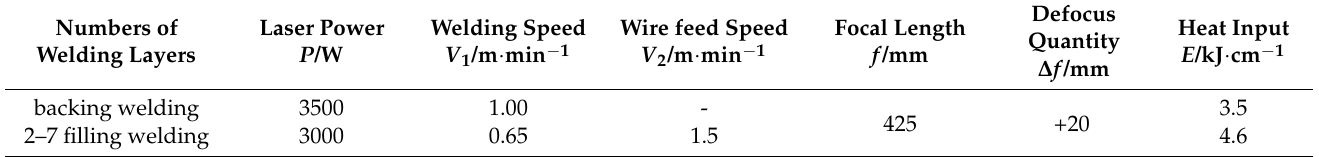
Figure 2. Macroscopic appearance of welded joint. Figure 3 is the microstructure morphology of the welded joint. It can be found that the largest grain microstructure appears in the WM. As their distance from the welded metal increases, the grains decrease gradually in dimension. Figure 3b – d are images of the microstructure of the WM under low and high magnification. From Figure 3b, a large number of columnar grains can be observed with an average width of 150 μ m. From Fig- ure 3c, we discover the eutectoid decomposition reaction of Ti-Fe is promoted by increas- ing the content of the Fe element in the flux-cored wire to 0.055 wt%. It can increase the probability of obtaining equiaxed grain microstructure and the contact area of the α ’ mar- tensite and incompletely transformed the β phase, then uplifting the area of heterophase boundaries, and finally realizing the optimization of the mechanical properties of the WM. It can be seen from Figure 3d that the interior of the coarse columnar grains is a bas- ketweave microstructure interwoven by acicular α′ martensite. During the rapid cooling and solidification process of the molten pool, β phases have no time to diffuse and thus shear to form a supersaturated α′ martensite solid solution. The α′ martensite grows and nucleates inside the original β columnar grains, first forming one or several paralleled primary α′ martensite, which extend through the whole grain in the length direction until